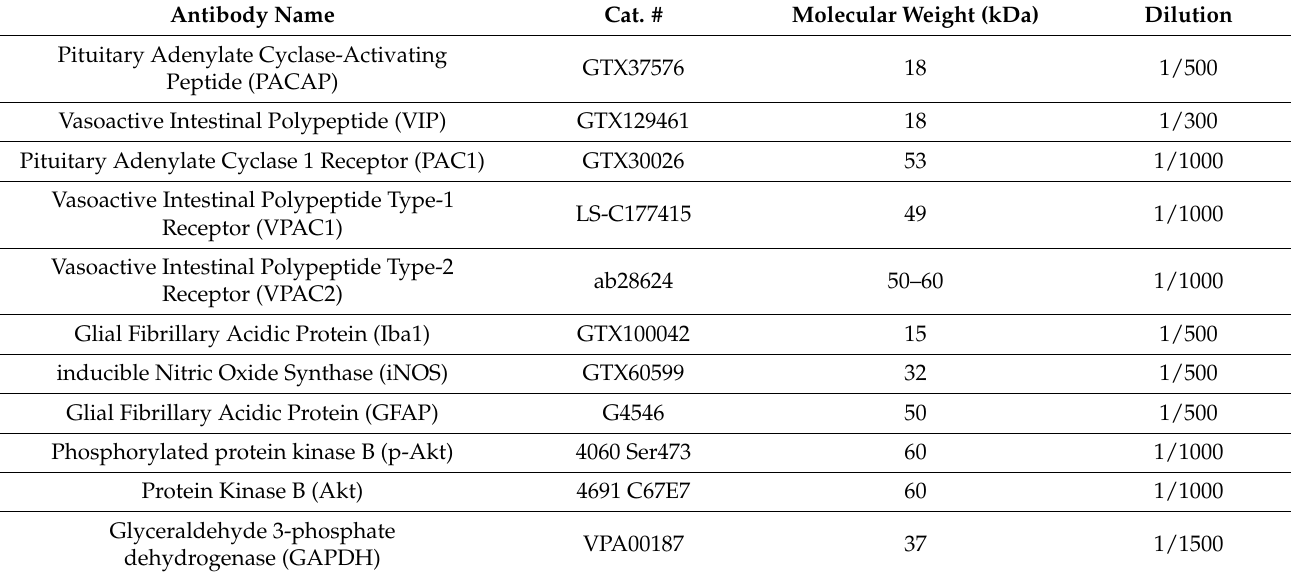
Table 2. Primary antibodies used for Western blotting. Optimal dilutions are shown in the right